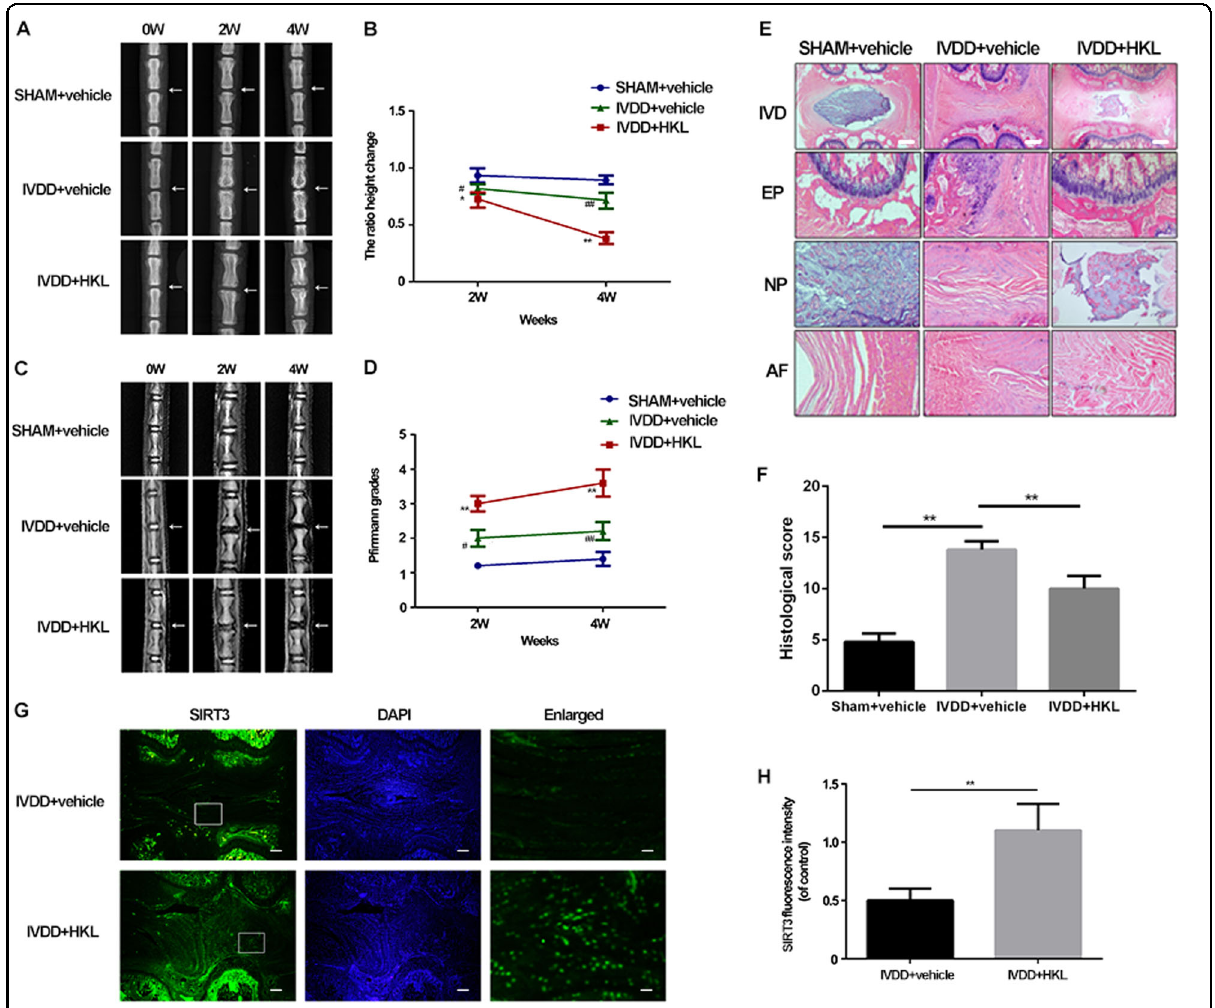
Fig. 7 HKL alleviates puncture-induced disc degeneration of rats in vivo. a Radiographic images of rat tails with a needle-punctured disc at 2 and 4 weeks after surgery (white arrows). b Disc height index (DHI) of rat tail. c, d T2-weighted MRI of a rat tail with a needle-punctured disc preoperatively and at 2 and 4 weeks postoperatively. The P fi rrmann MRI grade scores were acquired from three groups at weeks 2 and 4. e, f The morphology of the disc was examined using H&E staining. Scale bar: 100 μ M. g, h Immuno fl uorescence images of SIRT3 expression in the rat